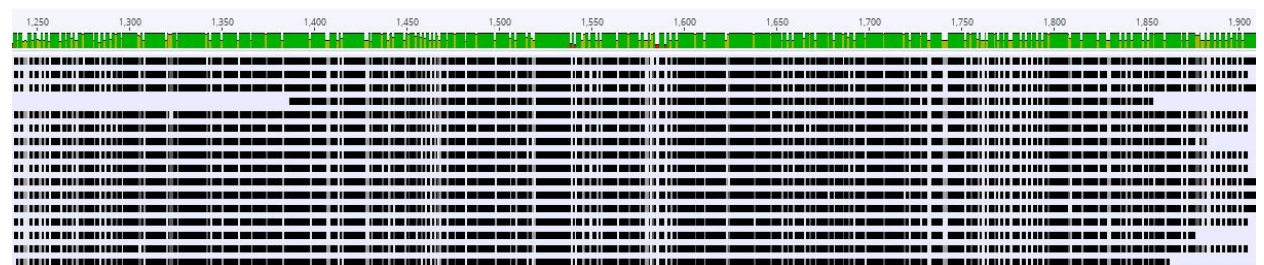
Figure 2. Multiple alignments of the coat protein–movement protein (CP-MP) region of 15 CaMMV isolates recovered from infected cacao ( Theobroma cacao L.) used in degenerate primer design. Light areas indicate nucleotide differences among sequences.